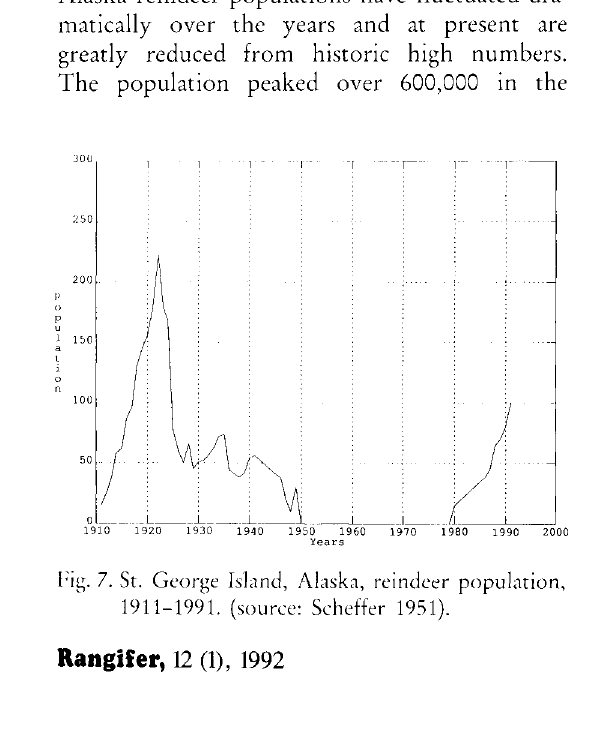
Fig. 7. St. George Island, Alaska, reindeer population, 1911-1991. (source: Scheffer 1951).